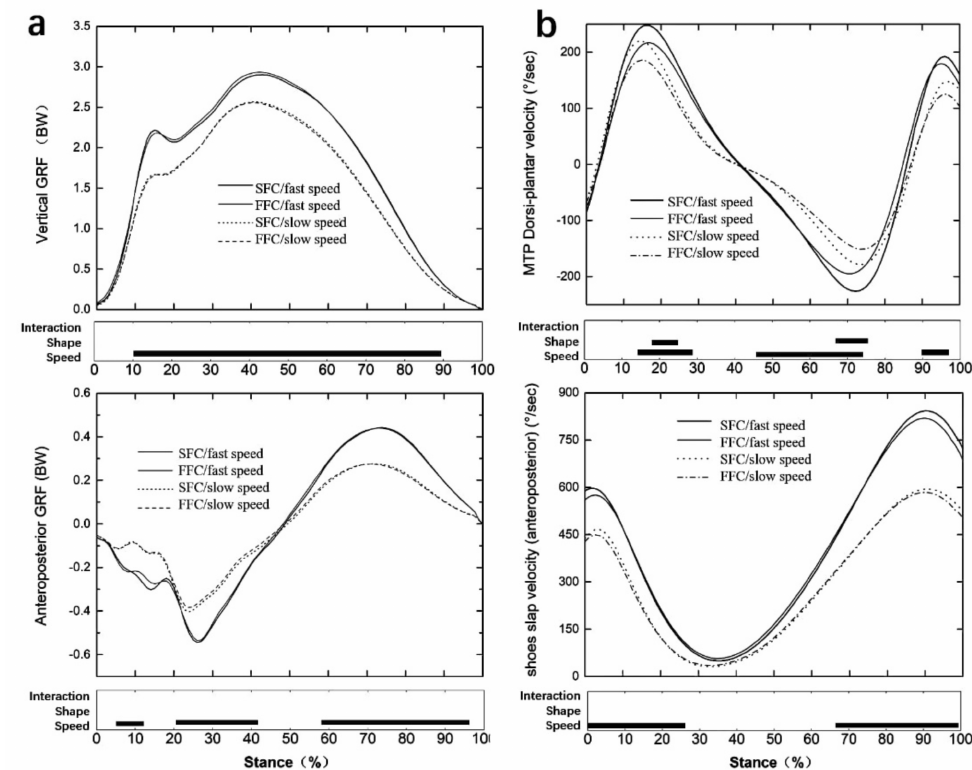
Figure 4. Vertical ground reaction force time ( a ) and anteroposterior ground reaction force time ( b ) (weight − normalized) (shoe slap velocity showed the shoe ground velocity).